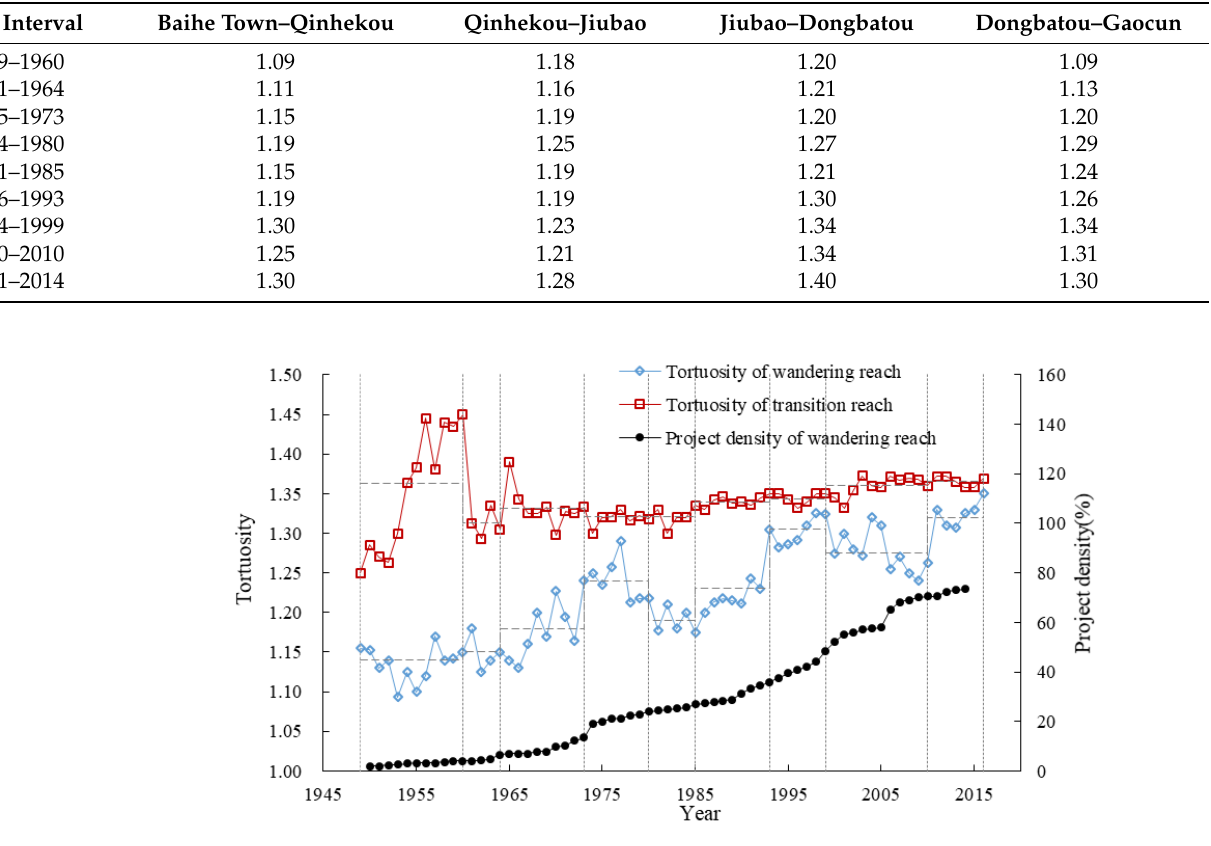
Figure 7. Variation in the bending coefficient and engineering density in different periods in the wandering reach.